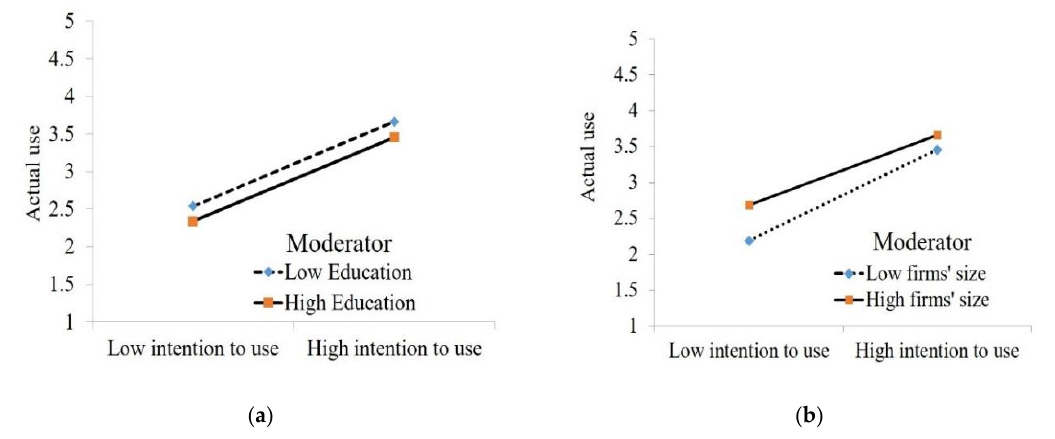
Figure 4. ( a ) Moderating effect of Education. ( b ) Moderating effect of Firms’ size.